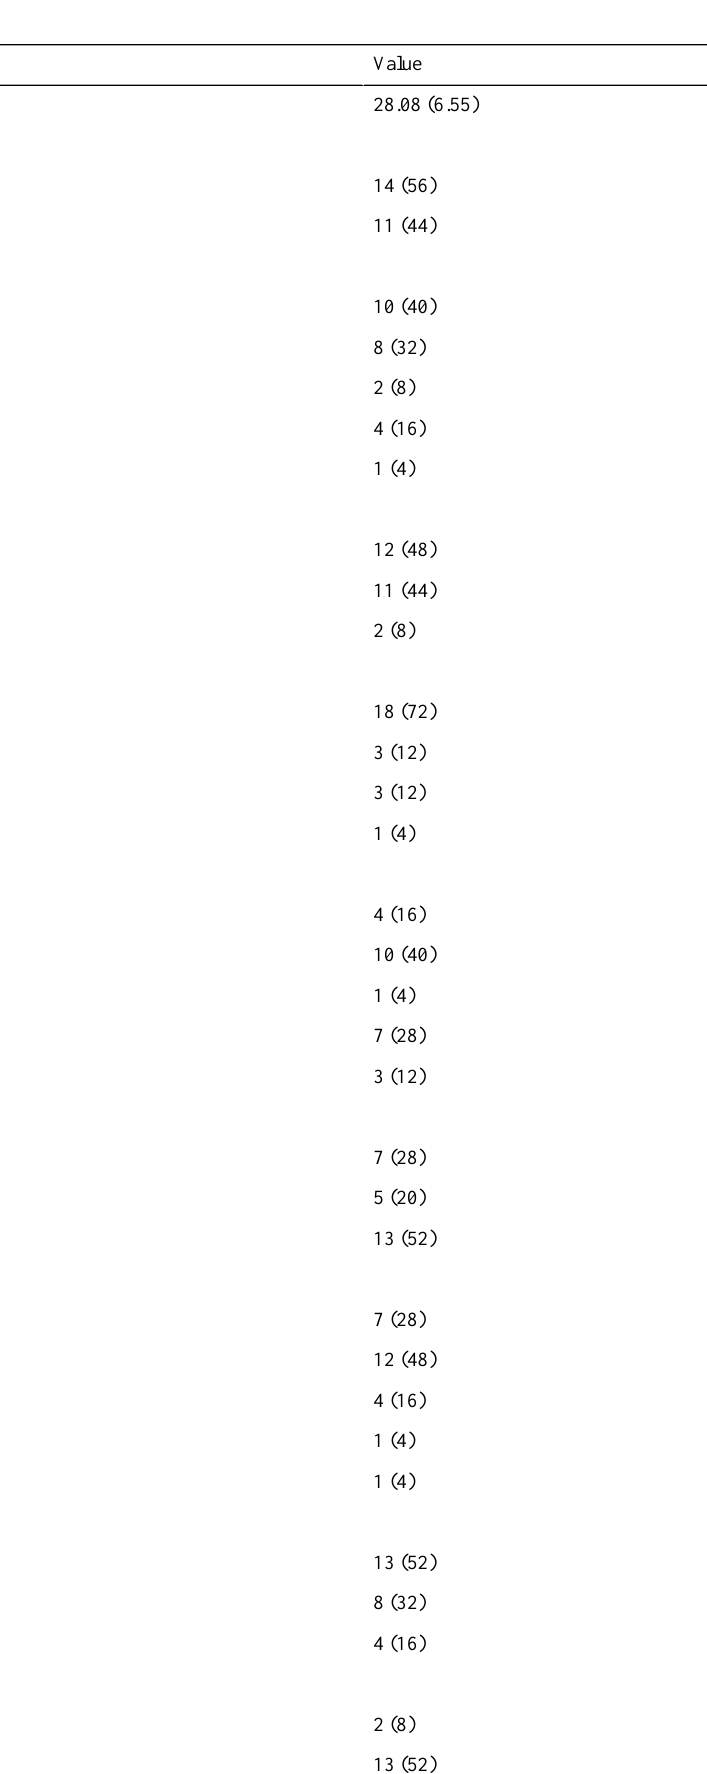
Table 1. Participant demographic characteristics